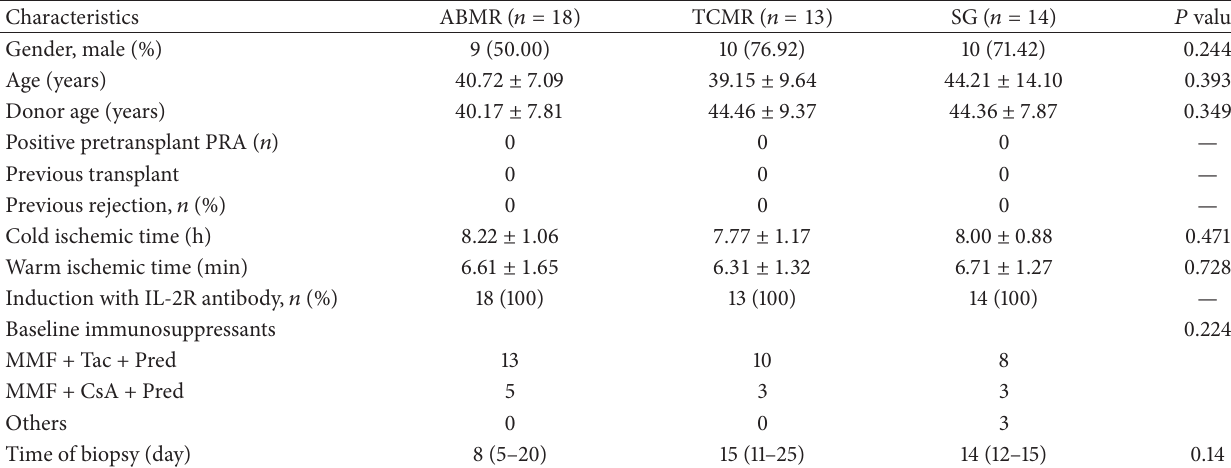
Table 1: Clinical characteristics of patients who participated in this